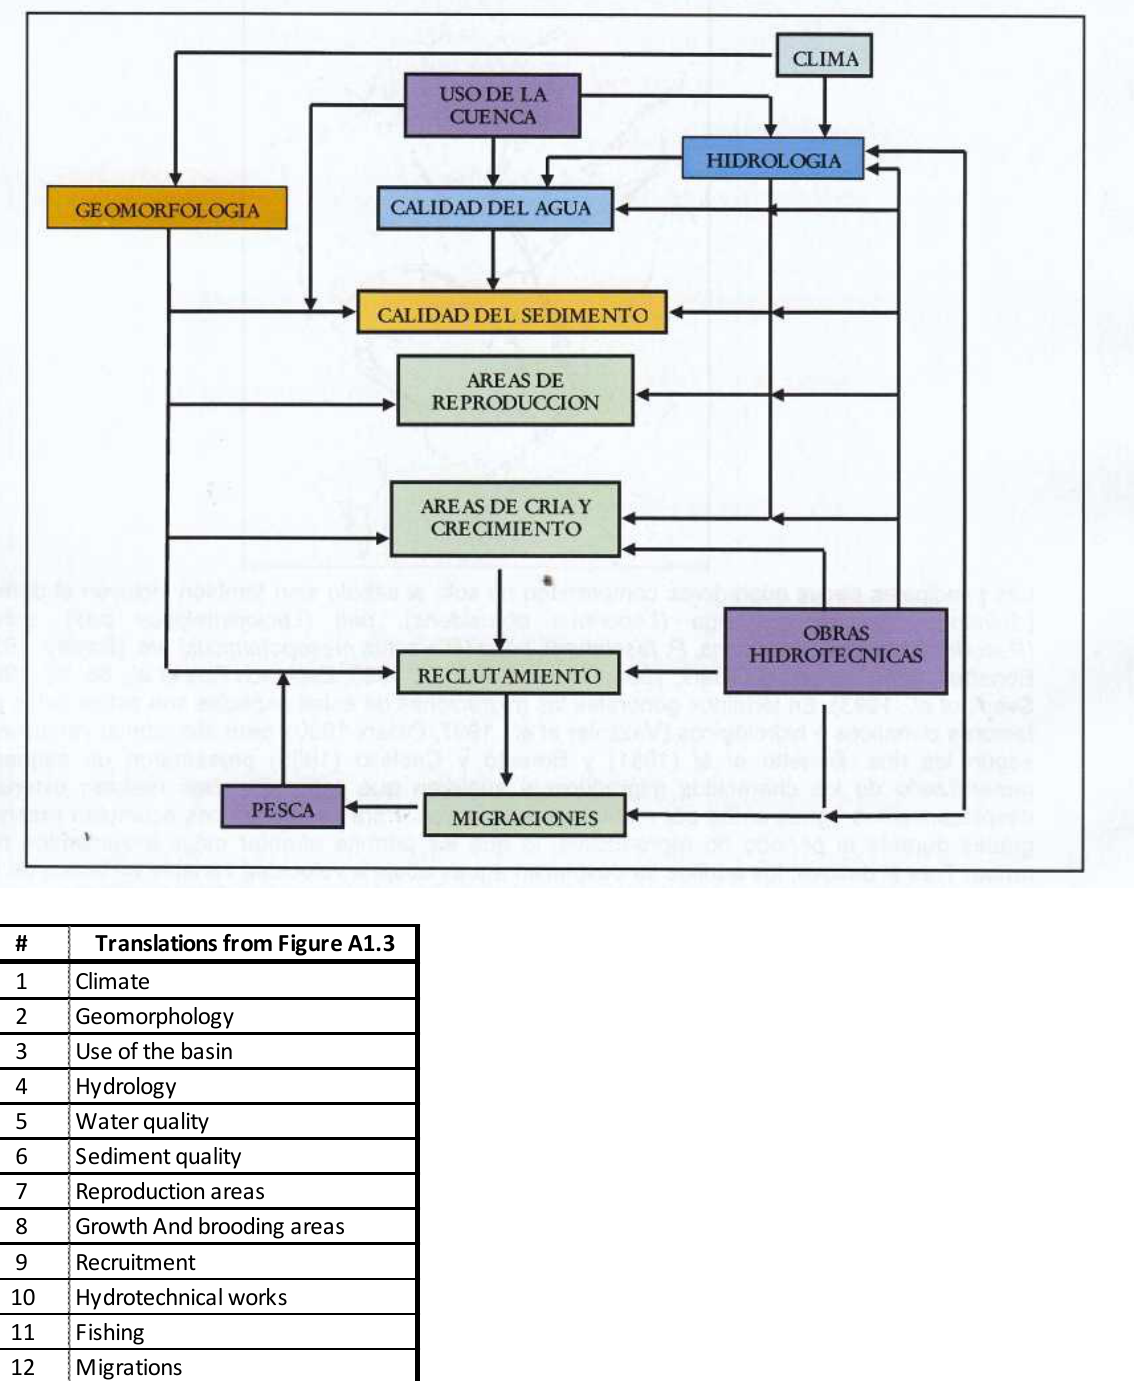
Figura 1-1 . Modelo conceptual de relaciones entre el desarrollo de diferentes etapas del cicl o biológico del sábalo con factores de origen natural y antrópico . Los cuadros en verde indican